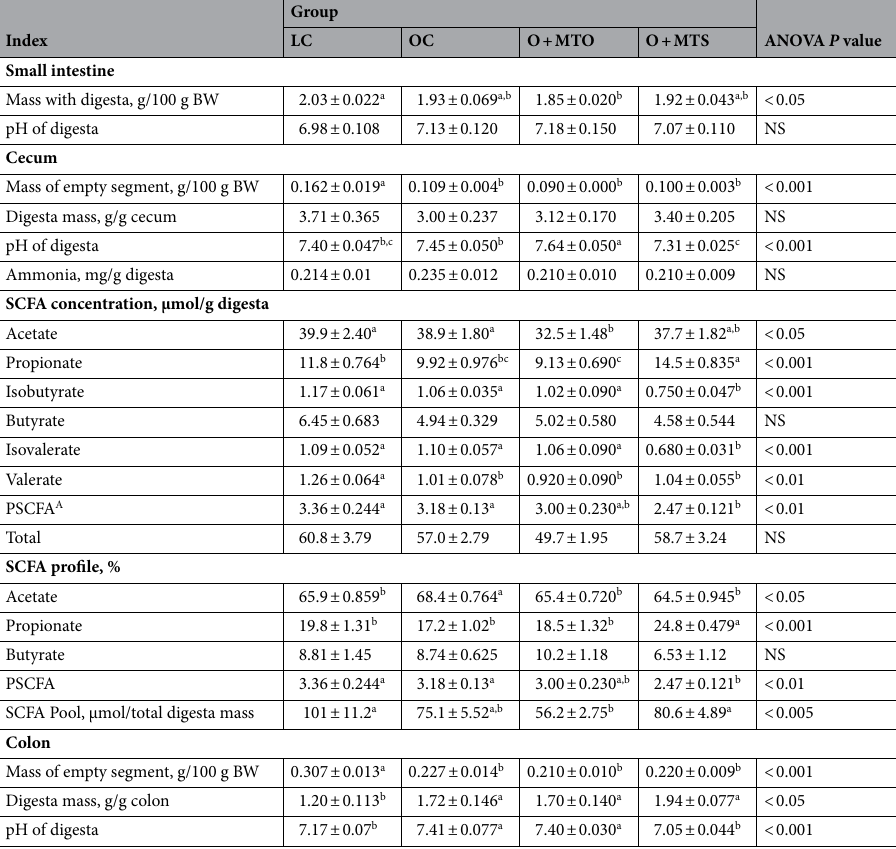
Table 4. Markers of the gastrointestinal tract function in lean and obese Zucker rats fed a diet containing milk thistle seed oil (+ MTO) or milk thistle seeds (+ MTS) for 5 weeks. Values are means ± SEMs, n = 7–8. Labeled means in a row without a common letter (a,b,c) differ at P ≤ 0.05 (Duncan’s or Dunn’s post hoc test). BW body weight, NS nonsignificant, P > 0.05, PSCFA SCFA of putrefactive origin, SCFA short-chain fatty acid, LC lean control, OC obese control, O + MTO obese fed a diet containing milk thistle seed oil, O + MTS obese fed a diet containing milk thistle seeds. A The sum of isobutyrate, isovalerate and